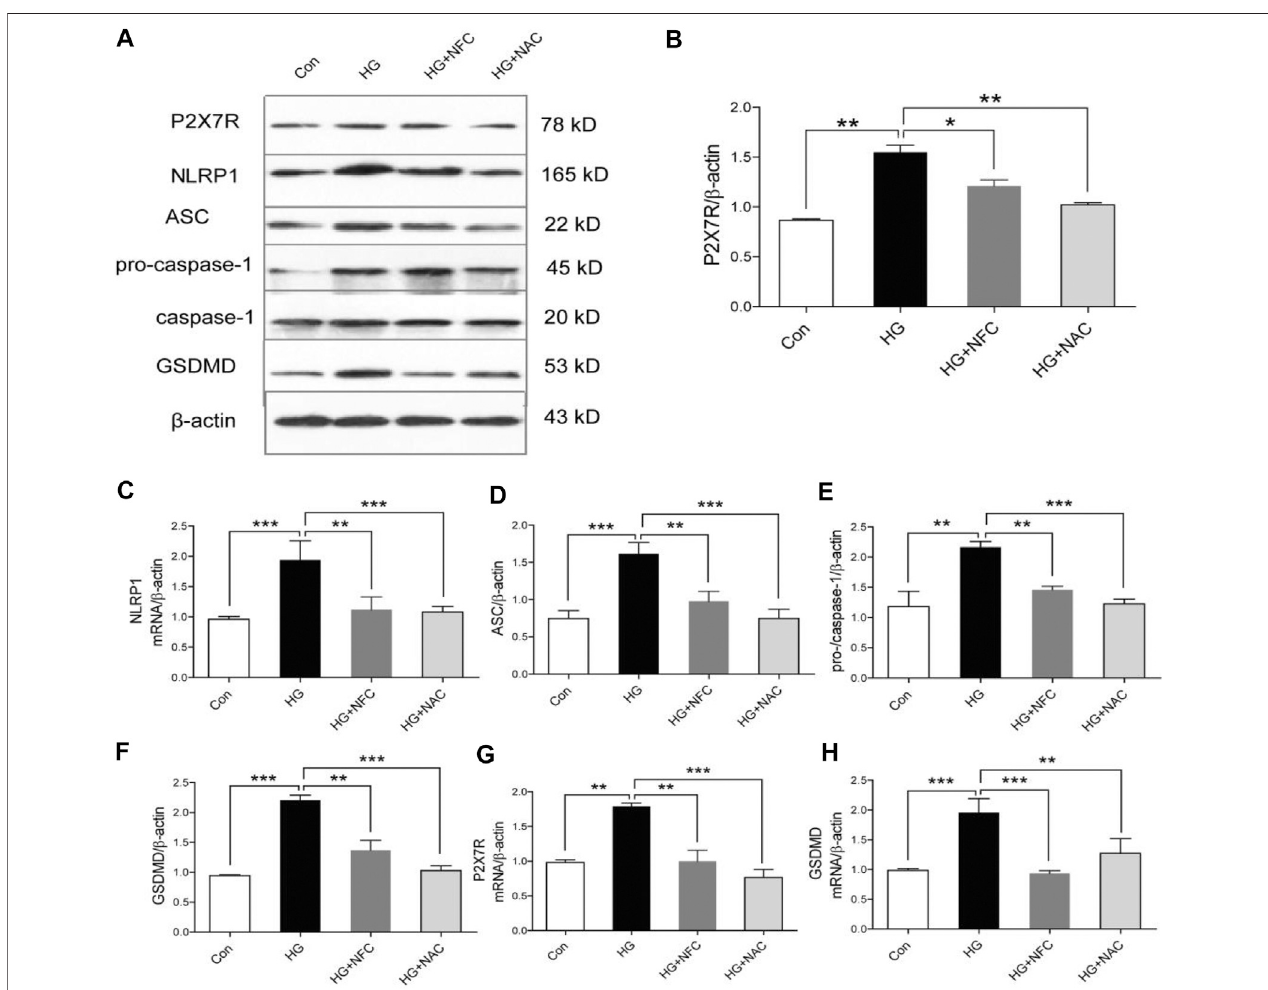
FIGURE 5 | Oxidative stress was involved in process of NFC suppressing P2X7/NLRP1/caspase-1 mediated neuronal injury in high glucose-induced HT22 cells. (A) Effects ofNAConP2X7R, NLRP1,ASC,pro-caspase-1,caspase-1,and GSDMDlevelsofHT22cellsinhighglucose. (B – F) Representativeprotein levelsofP2X7R, NLRP1,ASC,pro-caspase-1,caspase-1,andGSDMDlevelsofHT22cellsinhighglucosewereassessedbywesternblottingusingspeci fi cantibodies. (G,H) Effectsof NFC and NAC on NLRP1, and ASC mRNA levels of HT22 cells in high glucose. Values are means ± SEM, n (cid:2) 4 per group, * p < 0.05, ** p < 0.01, *** p < 0.001.